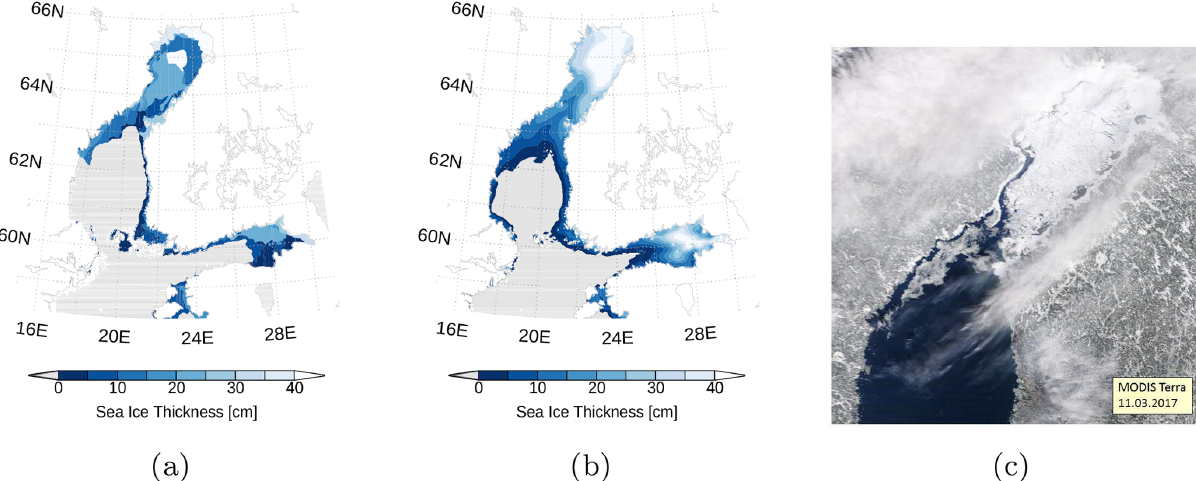
Figure 2. Sea ice thickness (a) at 12 March 2017 in the Bothnian Sea and the Bothnian Bay. Data are based on the Finnish Meteorological Institute’s ice charts and freely distributed by the Copernicus Marine Environment Monitoring Service (marine.copernicus.eu). Panel (b) is the same as (a) but from our model simulation. Sea ice coverage (c) , quasi-true color image derived from MODIS at 11 March 2017. The map in panels (a) and (b) was created using the software package GrADS 2.1.1.b0 (http://cola.gmu.edu/grads/, last access: 19 June 2020).